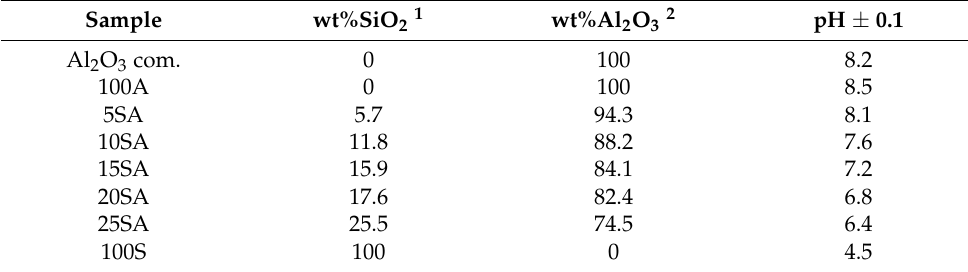
Table 7. Composition of the SiO 2 –Al 2 O 3 macrospheres calcined at 550 ◦